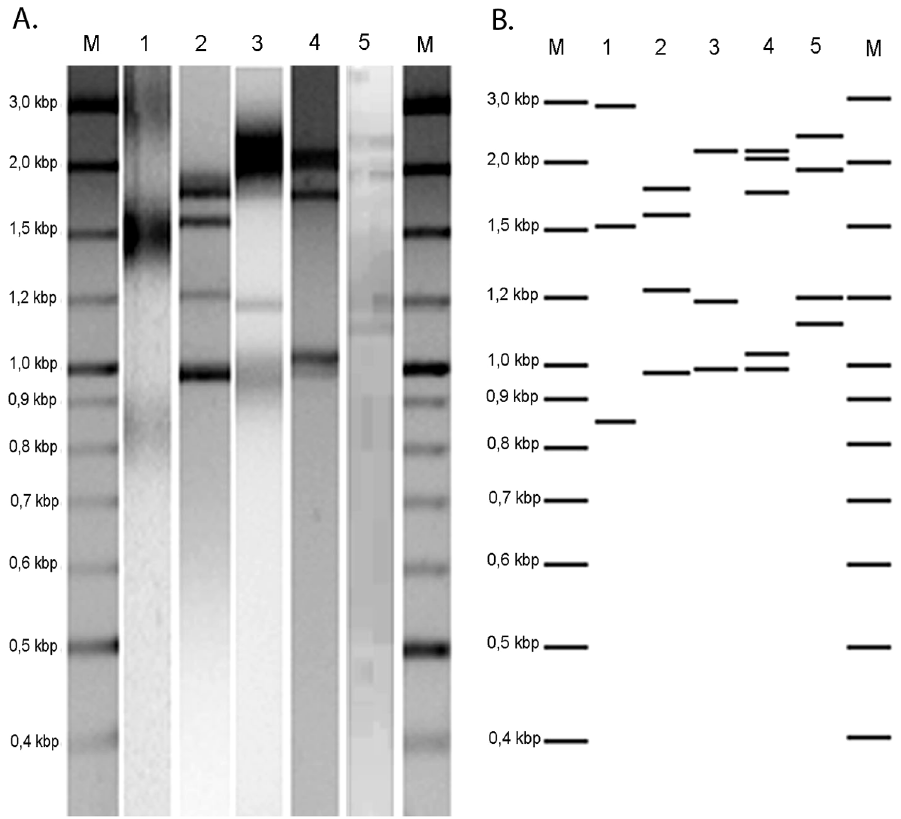
Figure 1. Five putative dsRNA patterns of the 16 mycovirus infected strains. A) Gel electrophoresis of isolated putative dsRNA patterns of A. fumigatus isolates, lane 1: dsRNA profiles observed in 11 isolates; lane 2: dsRNA profiles observed in 1 isolate; lane 3: dsRNA profiles observed in 1 isolate; lane 4: dsRNA profiles observed in 2 isolates and lane 5: dsRNA profiles observed in 1 isolate; lane M, DNA size marker. B) The dsRNA profiles displayed in lines.